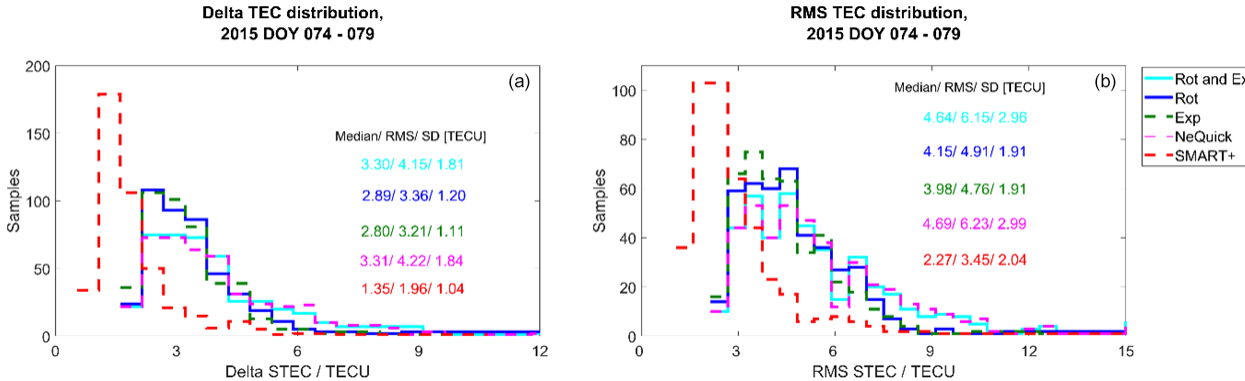
Figure 12. Plausibility check for the perturbed period. Distributions of the delta STEC (a) and RMS STEC (b)